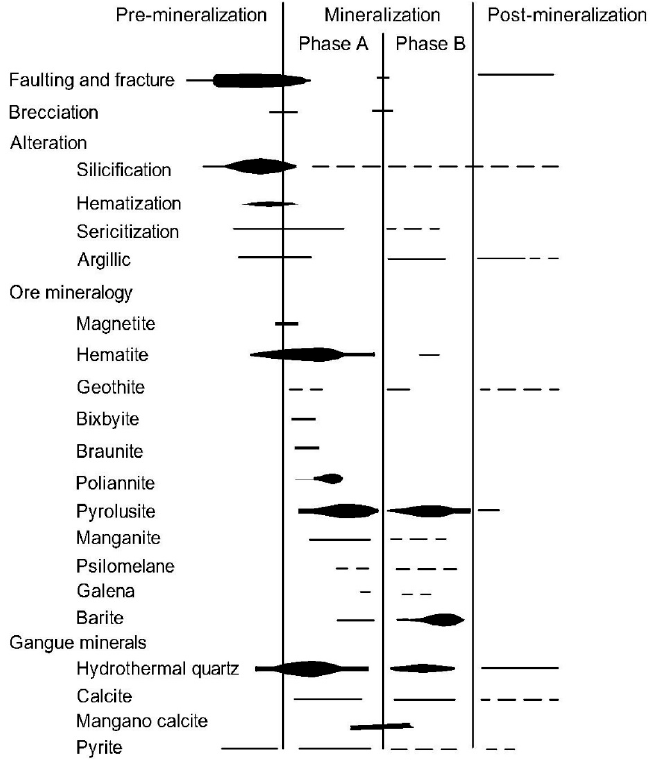
Figure 4. Simplified paragenetic sequence of events in the Tumanp ı nar ı area.